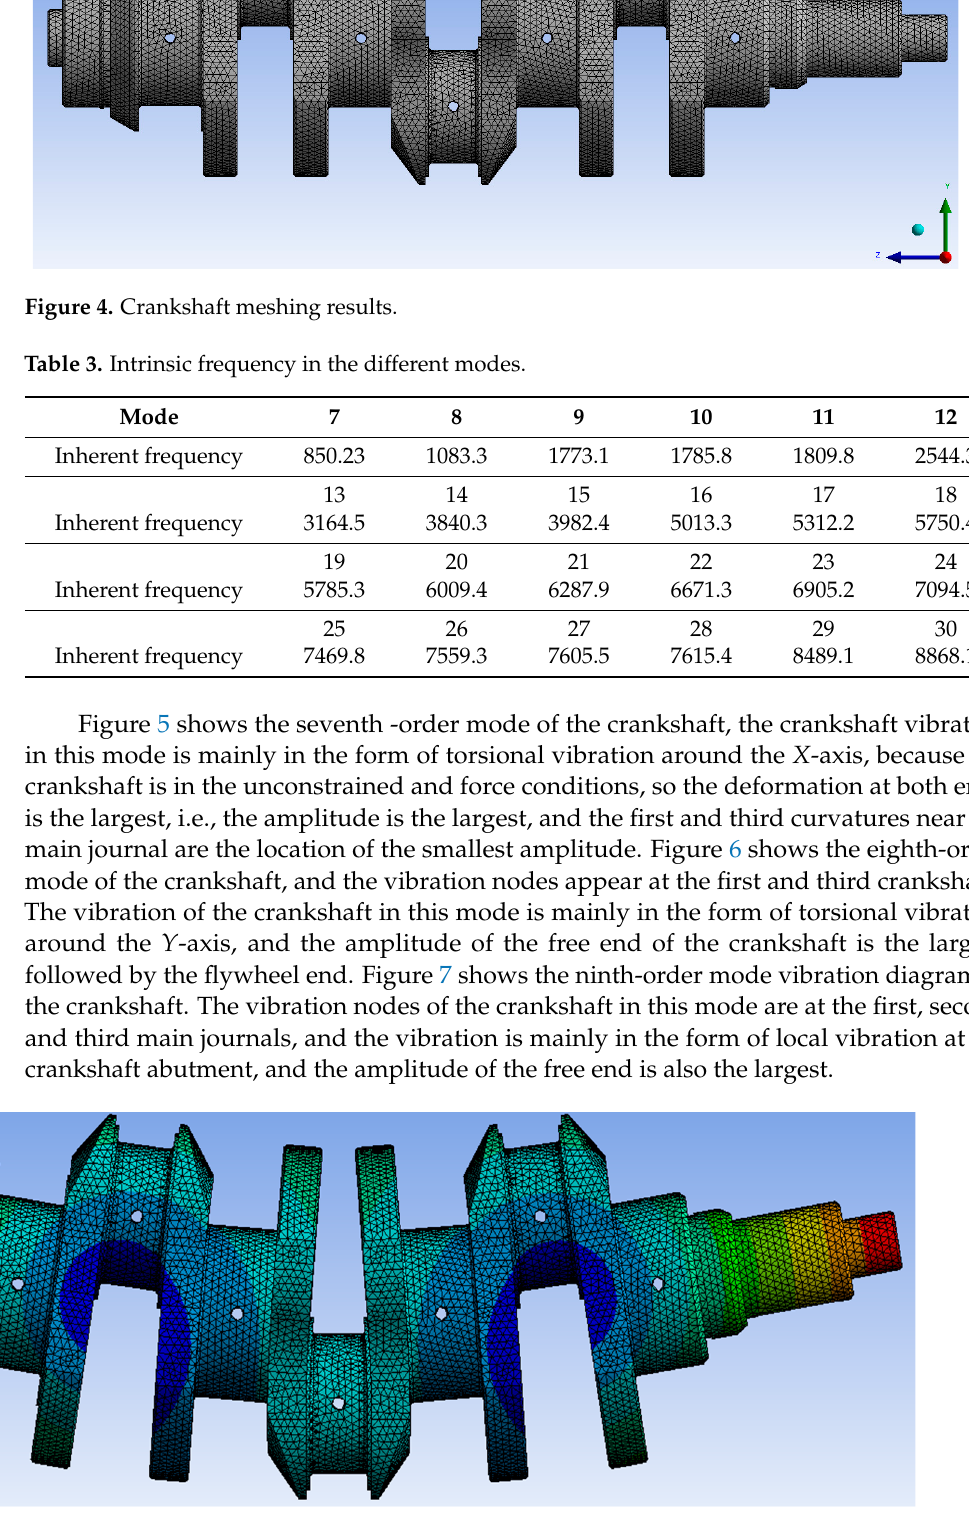
Figure 5. Seventh order mode vibration diagram.